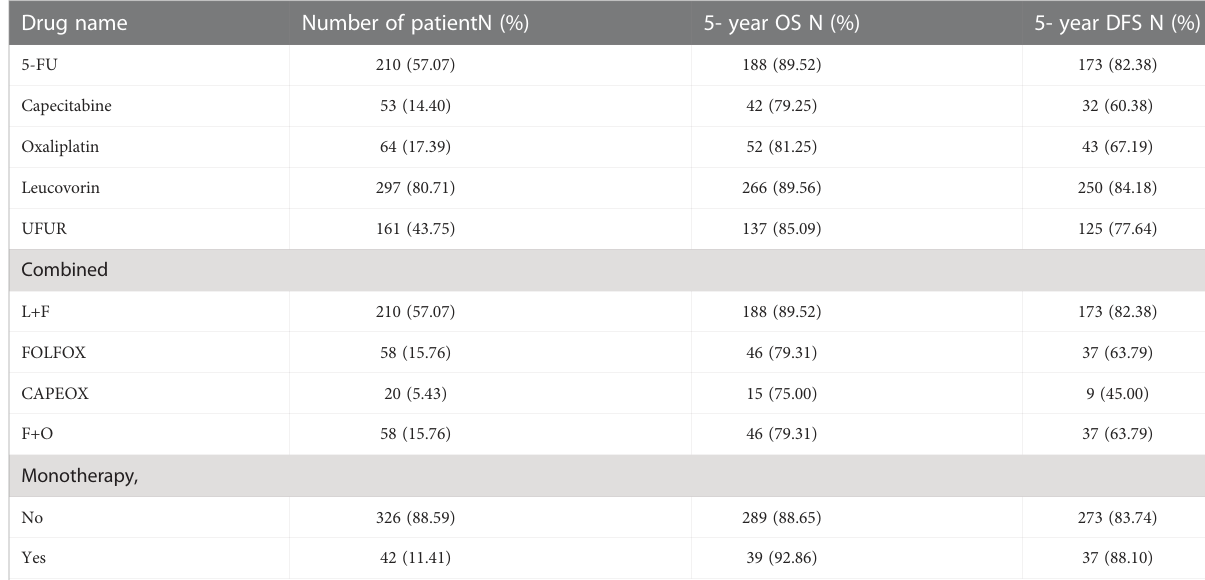
TABLE 4 The distribution and 5-year survival among different adjuvant chemotherapy regimens groups, n =368. Drug